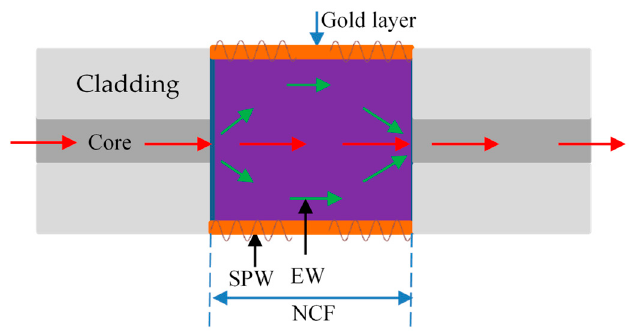
Figure 10. Schematic diagram of the DNA hybridization sensor [92].